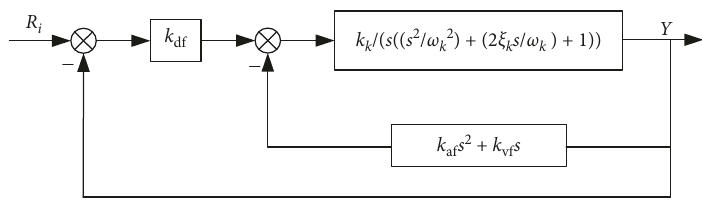
Figure 9: Block diagram of the three-state feedback control system.